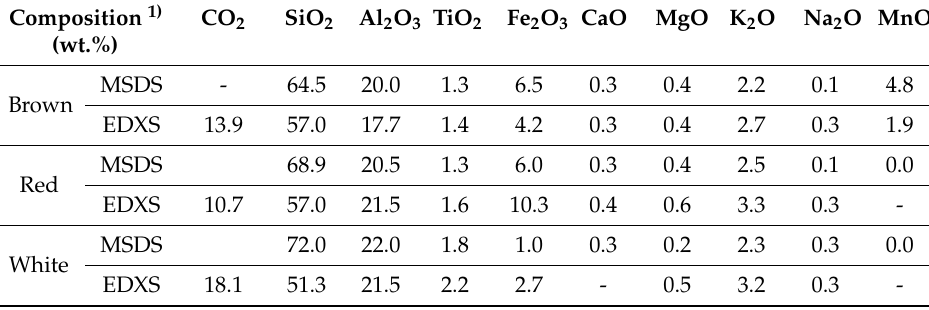
Figure S1: All ceramic cylinder membranes tested in the study, Figure S2: Photos of experimental set-up (left) and individual MFCs (right), Figure S3: Temporal change of peak power of test ceramics, Table S1: Chemical compositions and physical properties of tested ceramic materials, Table S2: Percentage relative volume of pores for test